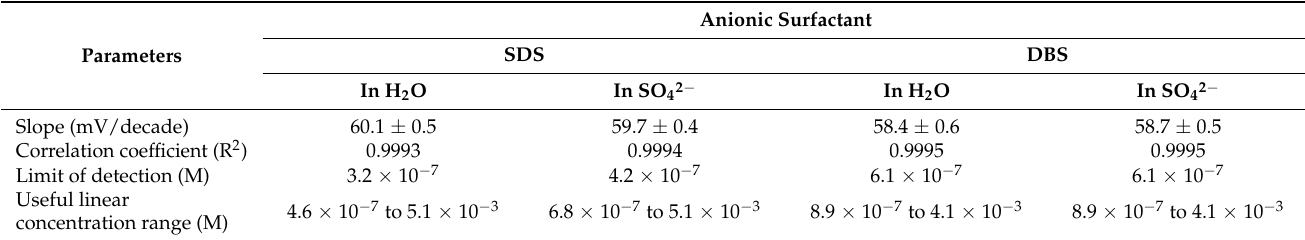
Table 1. Calculated response characteristics of DHBI-TPB surfactant sensor to anionic surfactants SDS and DBS measured in H 2 O and Na 2 SO 4 aq., at wide concentration range, with mean values at ± 95% confidence limits.